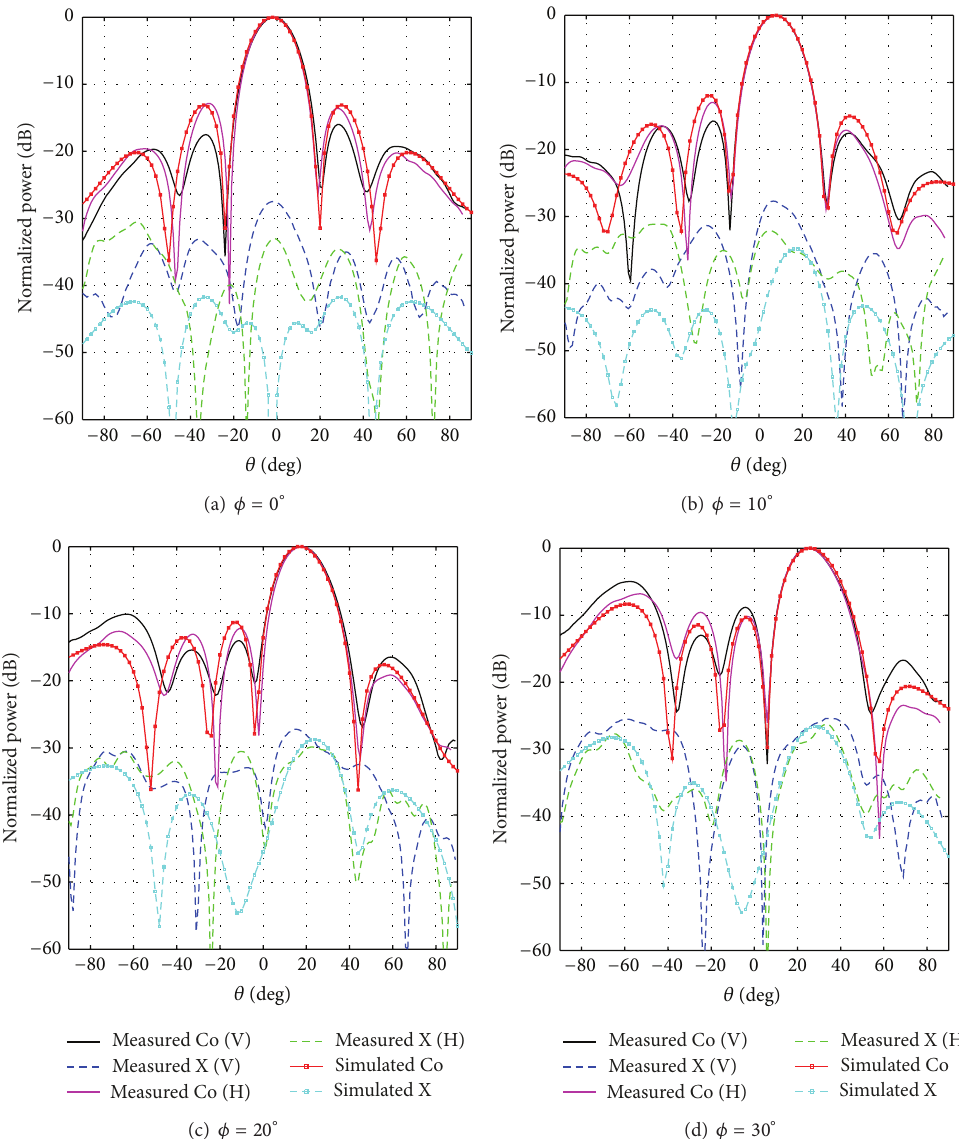
Figure 9: Measured polarimetric 4 × 4 planar array patterns and comparison with simulations. Beam-steering angle 𝜙 is in azimuth direction. Simulations are performed using